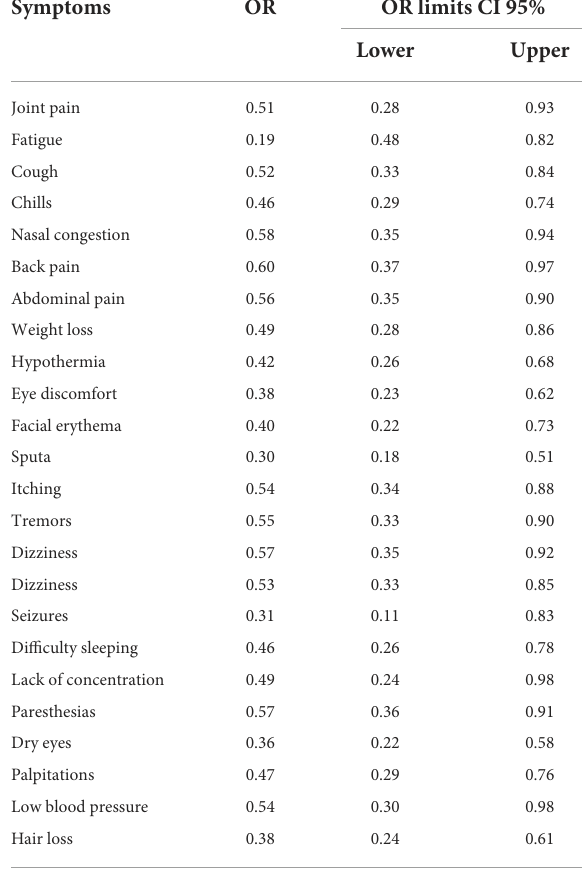
TABLE 5 Presence of pneumonia after COVID-19 diagnosis – symptoms of long COVID.